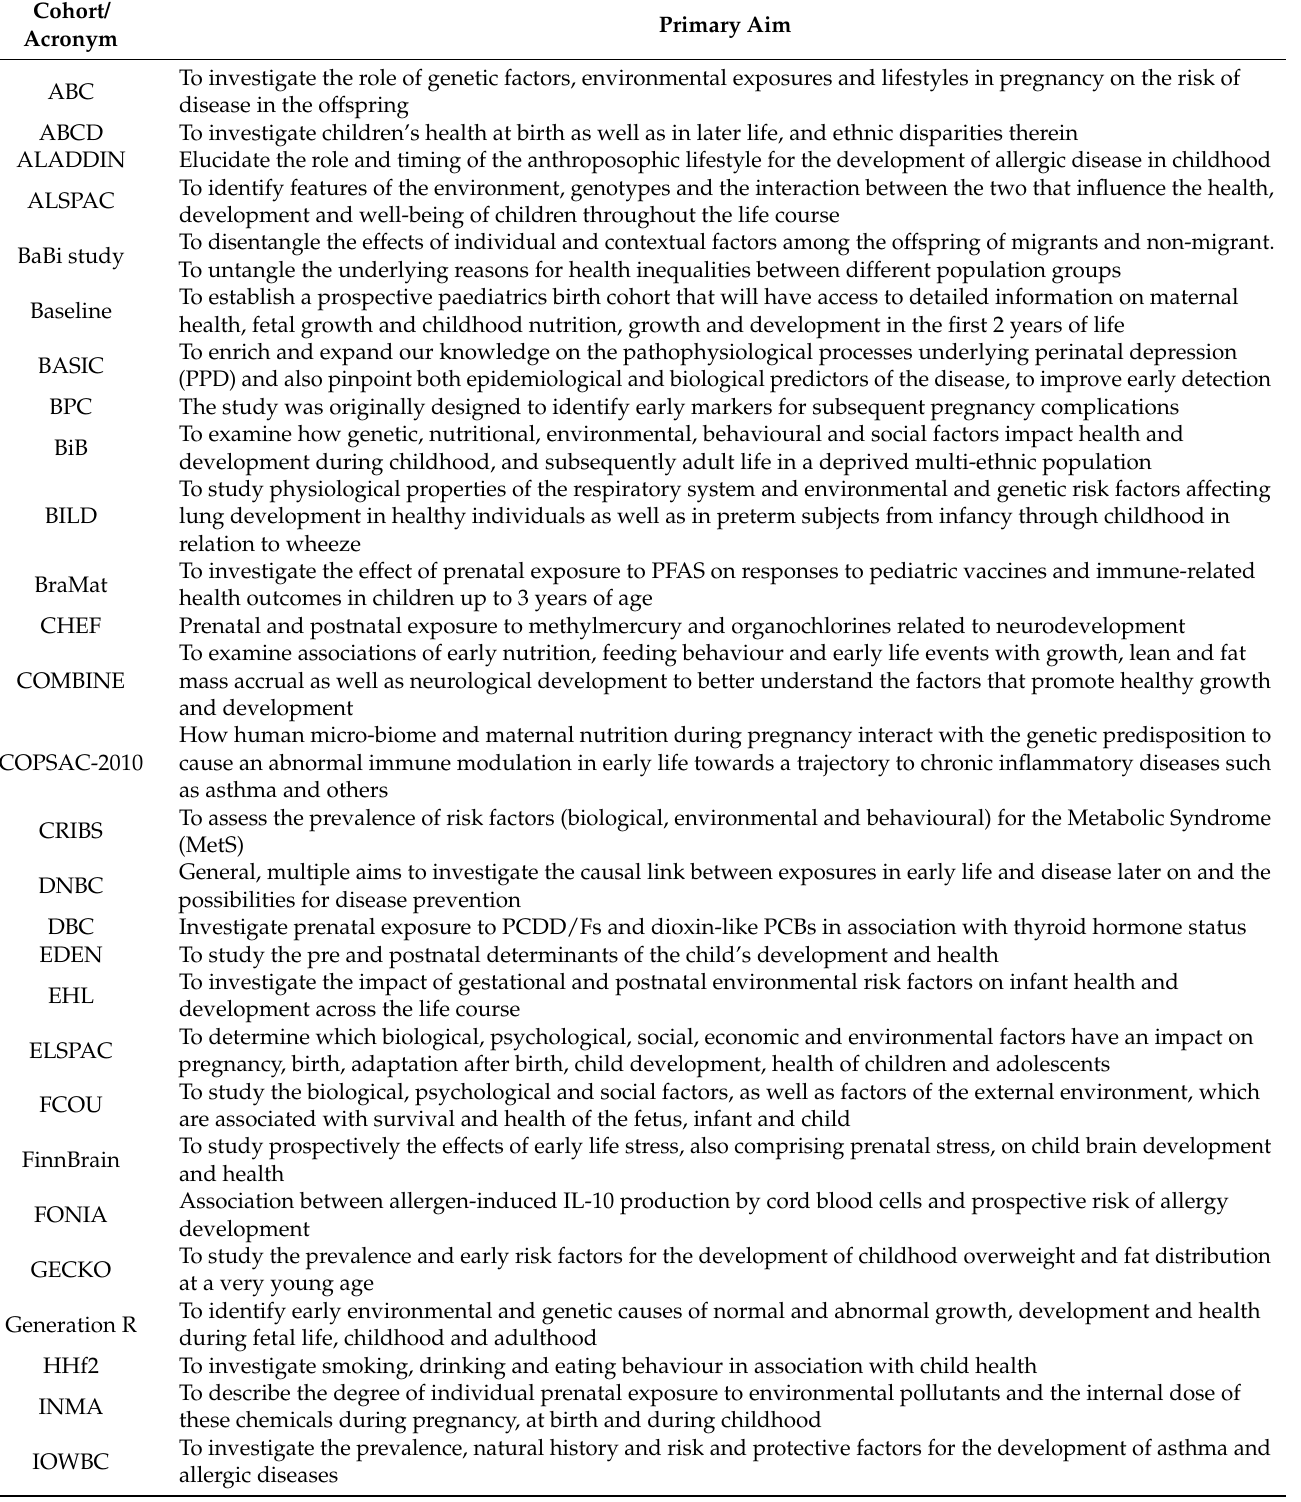
Table 1. Primary aims of the 66 pregnancy cohort